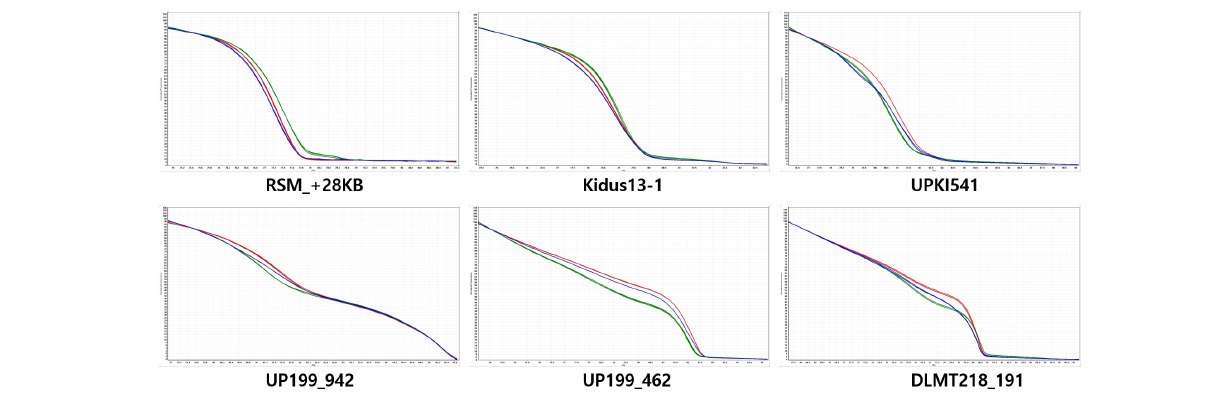
221 Mbp, with a physical distance of 3.58 Mbp and a genetic distance of 4.18 cM between them. Primers were then designed to narrow the candidate CapUp region. After sequencing the